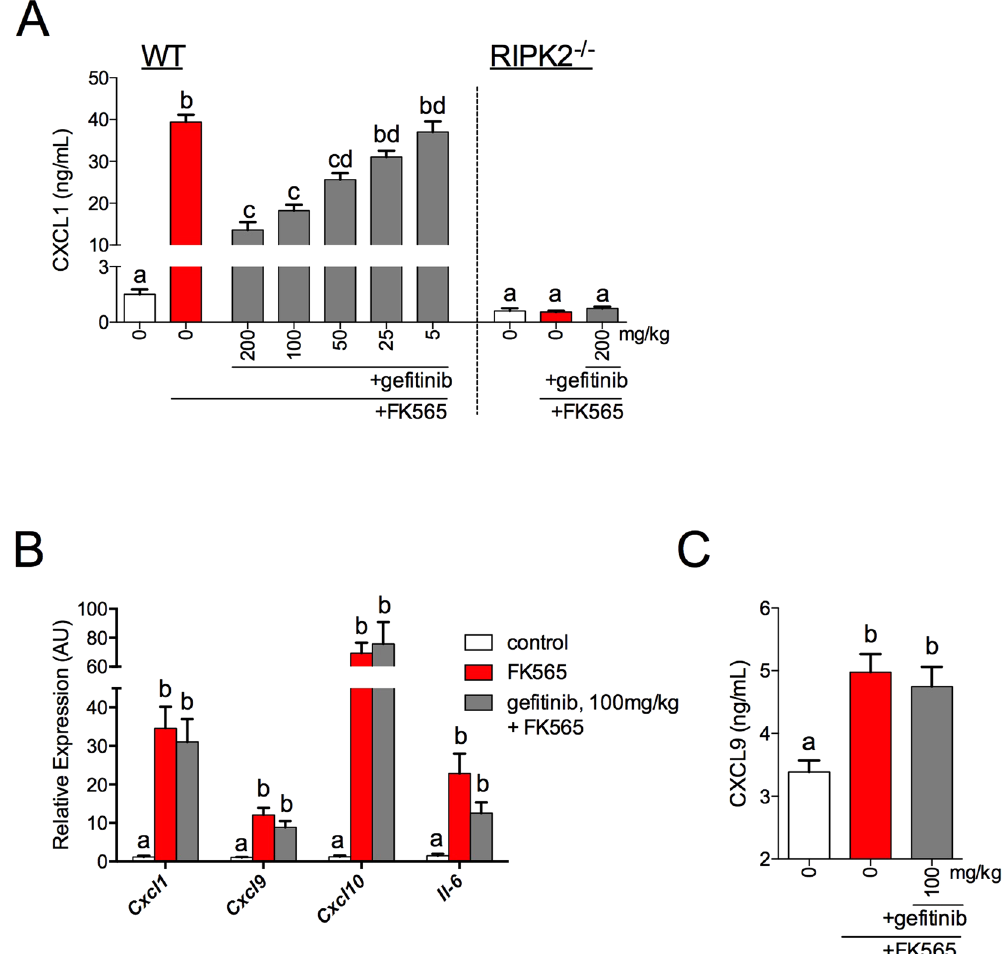
Figure 6. TKI gefitinib inhibits RIPK2-mediated inflammation in vivo . Cxcl1 secretion 2 h after injection with the Nod1 ligand FK565 (10 μ g, i . p .) in WT or RIPK2 − / − mice that were pre-treated with various doses of gefitinib (5–200 mg/kg) or methylcellulose vehicle for 4 days ( A ) n = 4–60 per group. Transcript analysis of Cxcl1, Cxcl9, Cxcl10 and Il-6 in adipose tissue 6 h after injection of FK565 (10 μ g, i . p .) in mice pre-treated with 100 mg/kg gefitinib or vehicle ( B ) n = 7–9. Protein levels of Cxcl9 in adipose tissue tissue 6 h after injection of FK565 (10 μ g, i . p .) in mice pre-treated with 100 mg/kg gefitinib or vehicle ( C ) n = 8–9. Values are mean ± SEM. Different letters assigned to each condition (a, b, c) denote statistical differences between groups (p <